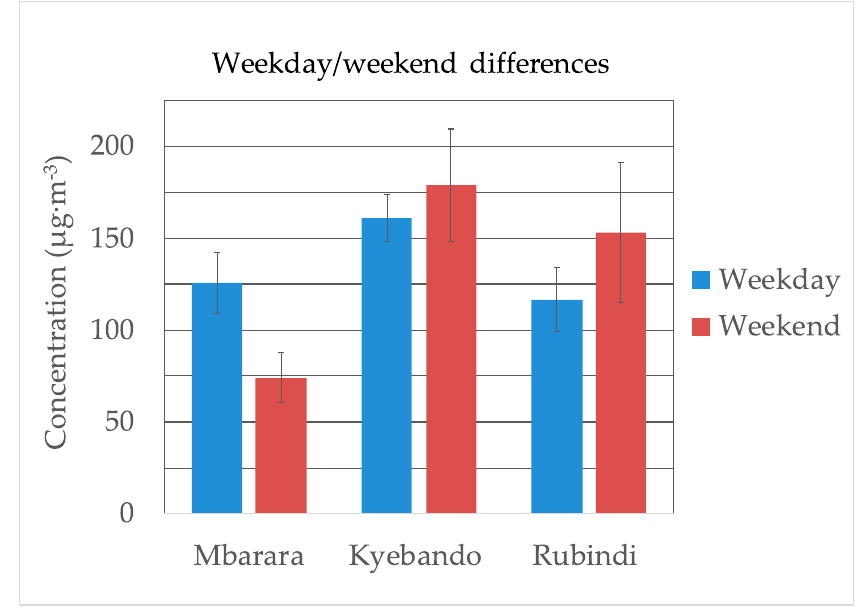
Figure 3. Comparison of weekday/weekend mean PM 10 concentration. Error bars represent one standard deviation of the mean.